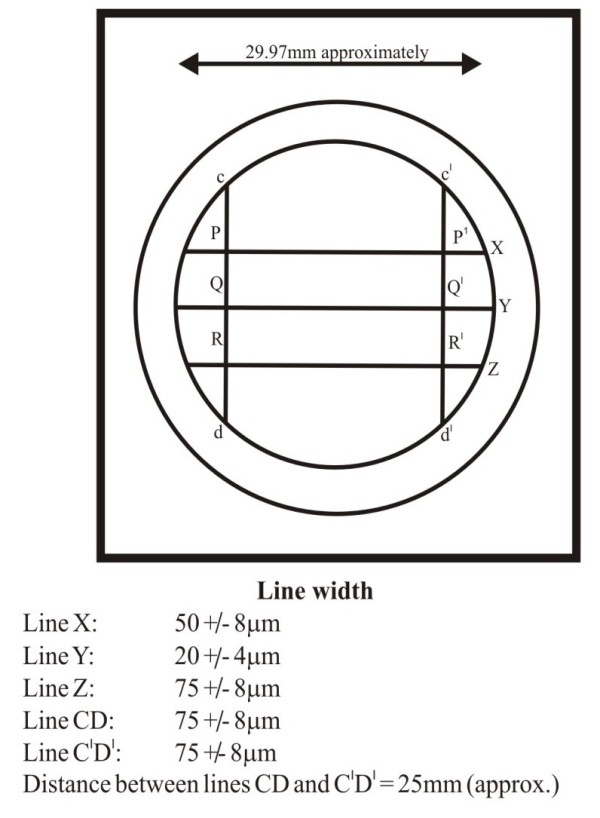
Schematic diagram showing ruledsurface of die.